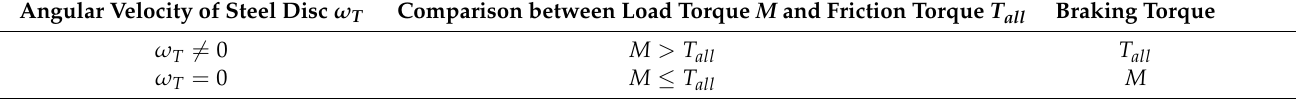
Table 1. Braking logic of friction pairs. Angular Velocity of Steel Disc ω T Comparison between Load Torque M and Friction Torque T